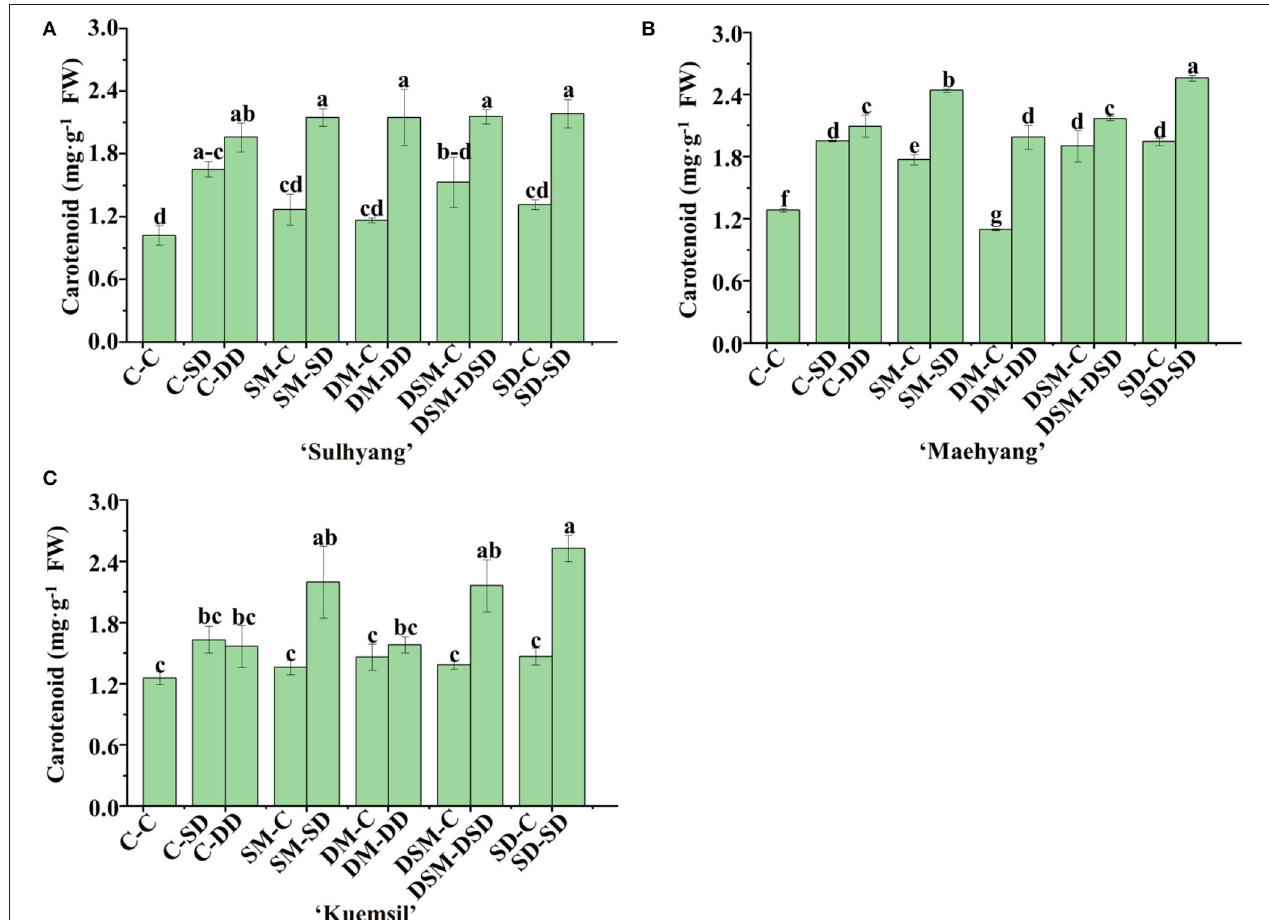
FIGURE 6 | Carotenoid content of strawberry transplants (A) “Sulhyang”; (B) “Maehyang”; and (C) “Kuemsil” as affected by the Si treatment after subjection to 43 ◦ C for 7 days. Lowercase letters indicate significant differences calculated by the Duncan’s multiple range test at p ≤ 0.05. See Figure 1 for descriptions of treatment